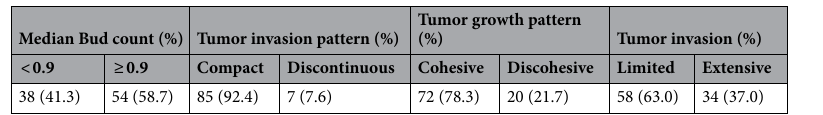
Table 2. Frequency of tumor budding, tumor invasion pattern, tumor growth pattern, and invasion.